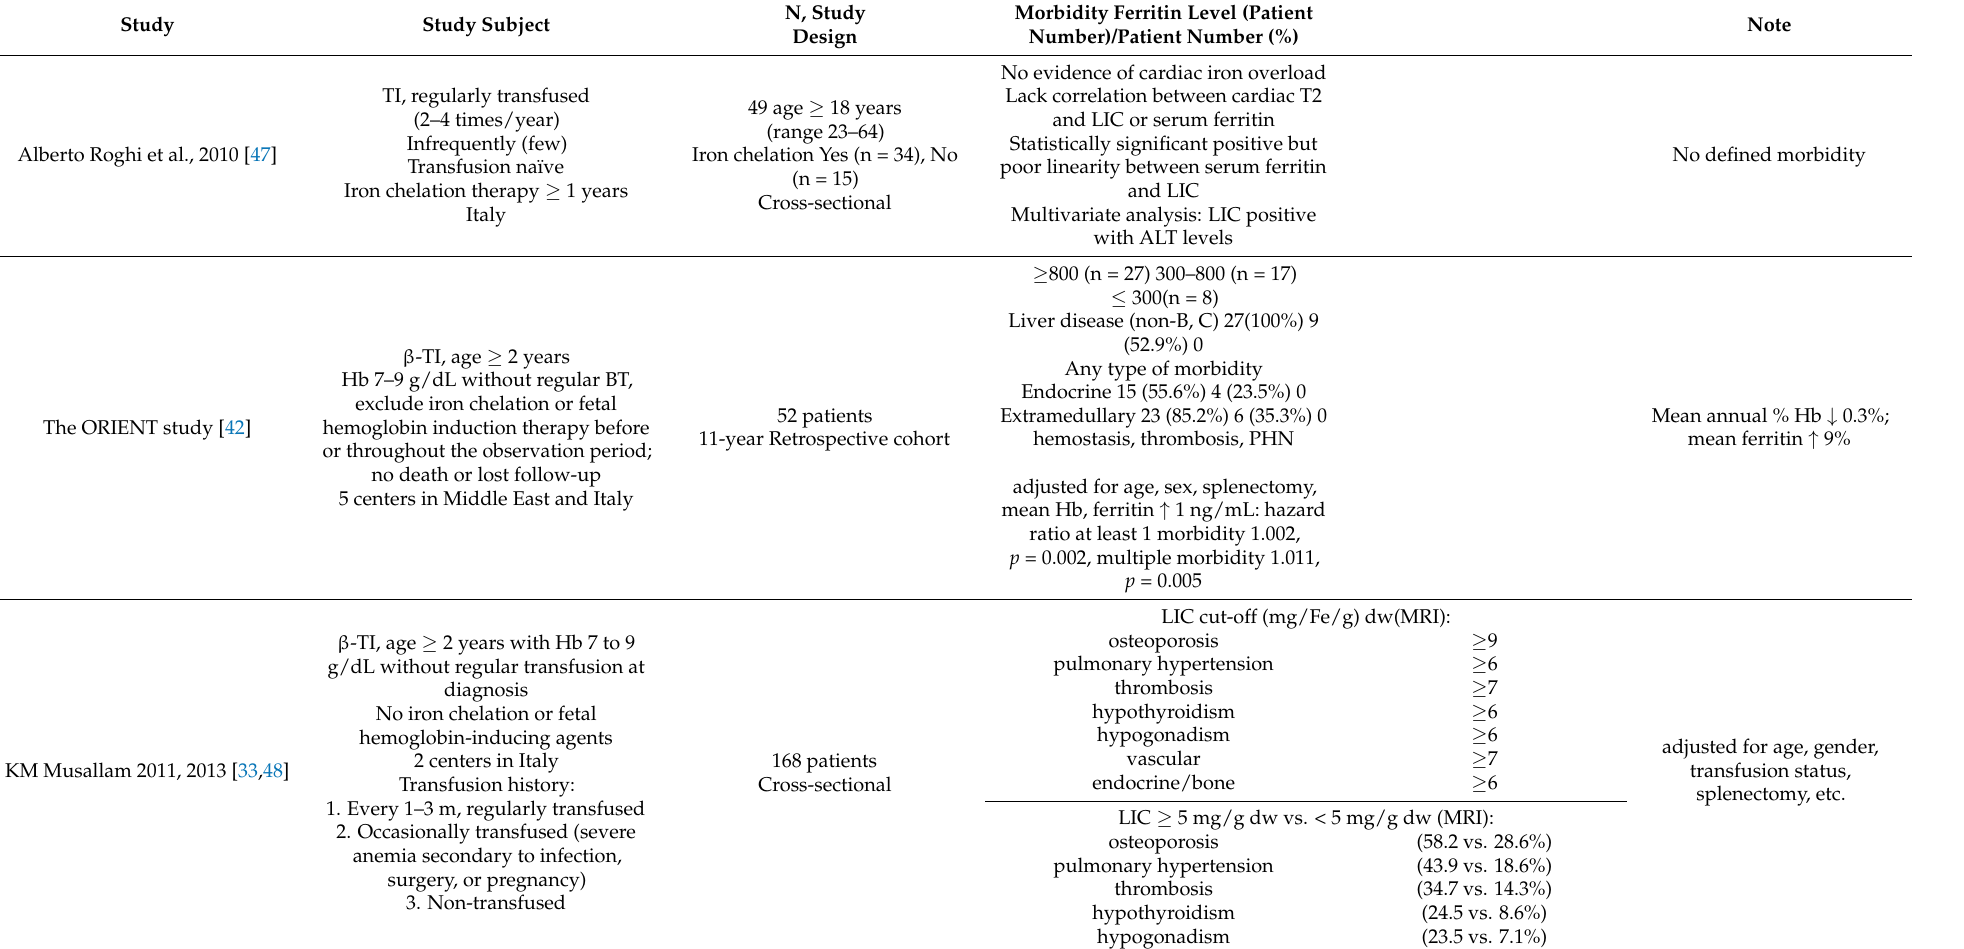
Table 4. Ferritin level and related